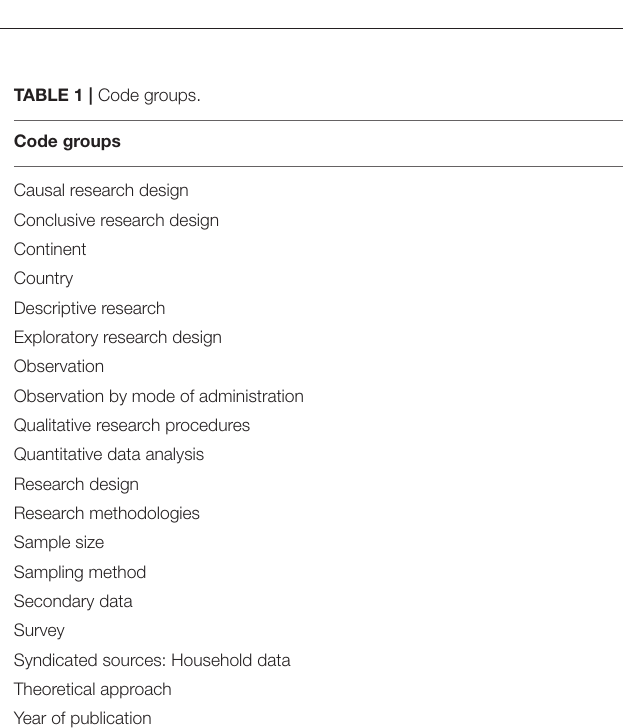
FIGURE 1 | Study selection